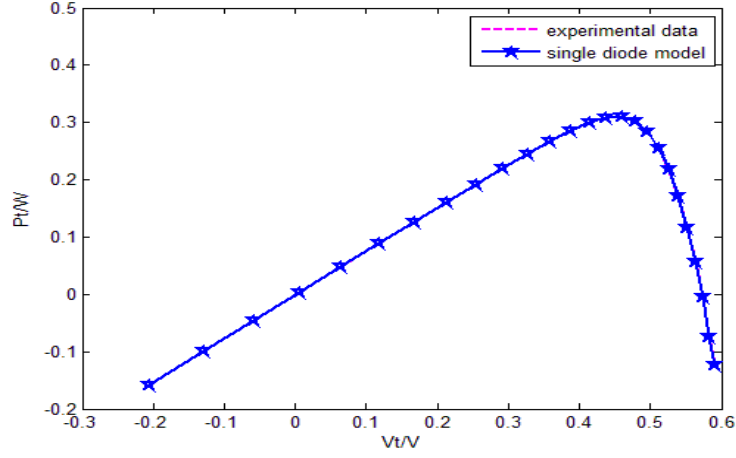
Figure 8. Comparison between the P - V characteristics resulting from the experimental data and the single diode model.